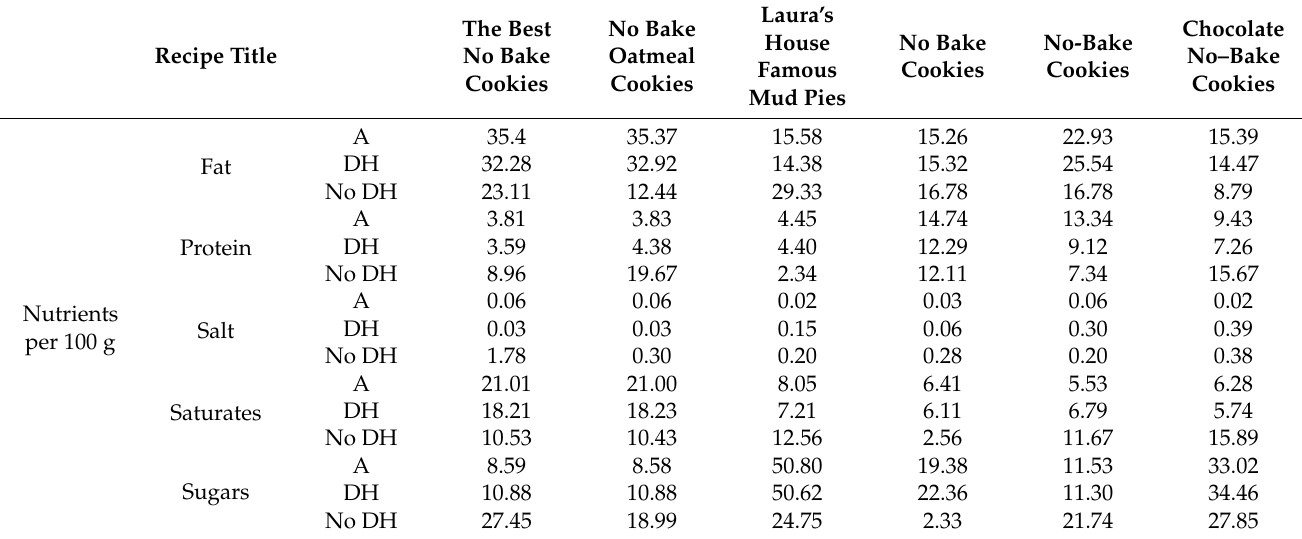
Table 4. Differences in performance space (A–Actual value, DH–Predicted value when using the domain heuristic, No DH–Predicted values without using the domain heuristic).